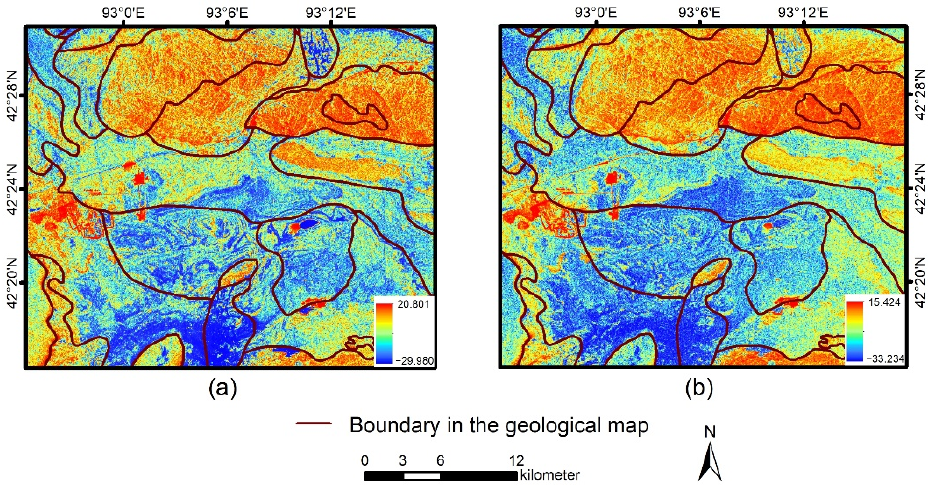
Figure 5. Backscatter coefficients extracted from Sentinel-1 collected on 8 August 2020: ( a ) results of VV polarization and ( b ) results of VH polarization.